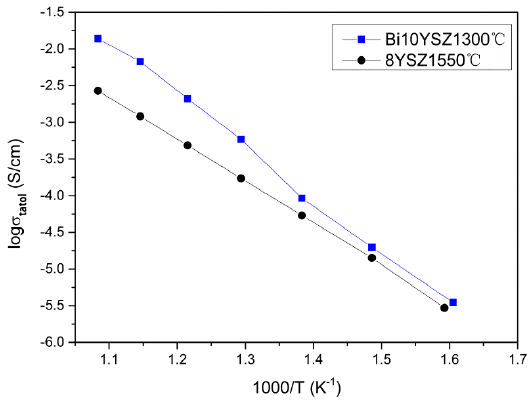
Figure 9. Arrhenius curve of 8YSZ sintered at 1550 °C and 2Bi-10YSZ sintered at 1300 °C.